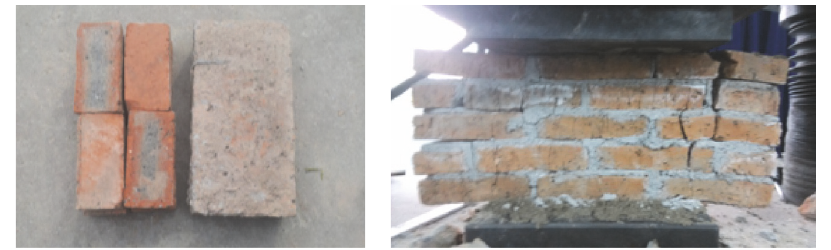
Figure 1: Clay bricks used in the experimental